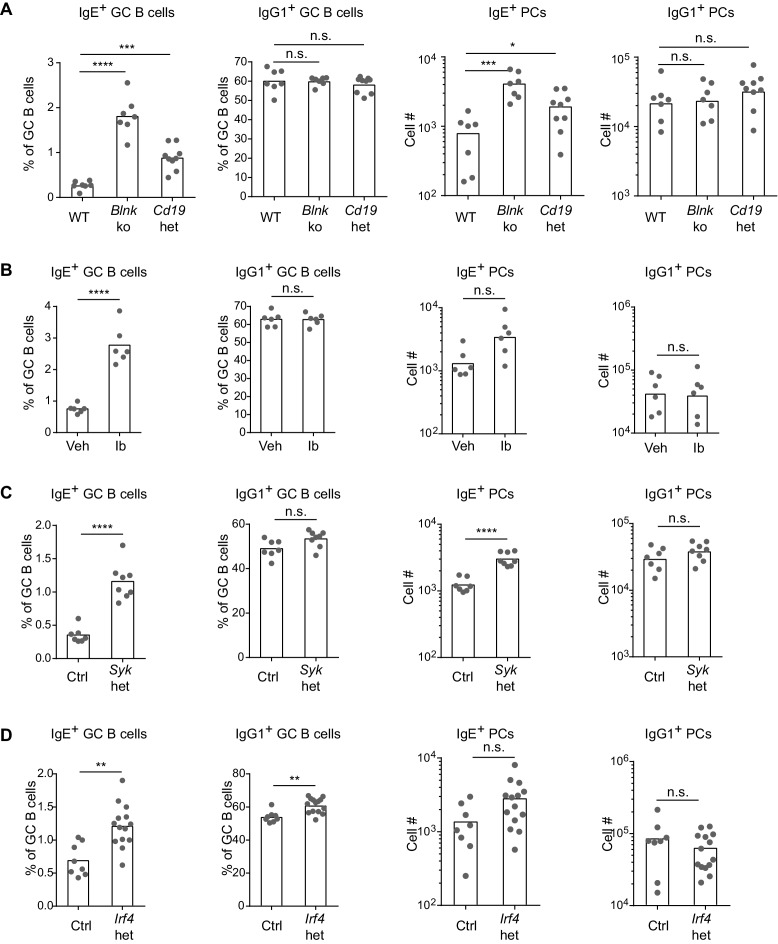
BCR signaling negatively regulates in vivo IgE+ responses.Mice were immunized subcutaneously with NP-CGG in alum adjuvant and draining lymph nodes were analyzed by flow cytometry 9 d later. (A to D) Quantification of frequency of IgE+ and IgG1+ cells among GC B cells and the total number of IgE+ and IgG1+ PCs in wild-type (WT) versus Blnk–/– (Blnk ko) versus Cd19Cre/+ (Cd19 het) mice (A), Captex 355 vehicle (Veh) versus ibrutinib (Ib)-treated mice (B), control Syk+/+ Cγ1Cre/+ (Ctrl) versus Sykflox/+ Cγ1Cre/+ (Syk het) mice (C), control Irf4+/+ Cγ1Cre/+ (Ctrl) versus Irf4flox/+ Cγ1Cre/+ (Irf4 het) mice (D). The total number of lymph node cells and GC B cells are provided in Figure 5—figure supplement 1. An analysis of somatic hypermutation related to (C) is provided in Figure 5—figure supplement 2. PCs were CD138+B220lo-intCD38loIgDlo and intracellular IgEhi or total IgG1hi. GC B cells were CD138–B220hiPNAhiCD38loIgDlo and intracellular IgEint or total IgG1int. Dots represent individual mice. Bars represent the mean (% of GC B cells) or geometric mean (cell number). Data are representative of two (A), three (C), and four (B) independent experiments. n.s., not significant; **p<0.01; ***p<0.001; ****p<0.0001 (one-way ANOVA followed by Dunnett’s post-test (A), t-tests with the Holm-Sidak correction for multiple comparisons (B–D); the numbers of PCs were log transformed for all statistical tests).